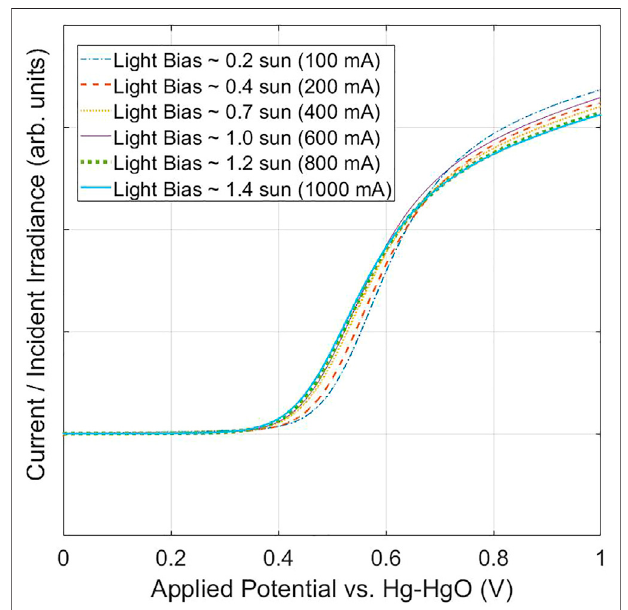
FIGURE 2 | Photocurrent normalized by light intensity vs. applied potential,forvariousintensitiesoftheLEDwhitelightsource.Thelightintensity was determined by a fi tted calibration curve of light intensity vs. LED current, the former measured with a spectroradiometer and integrated over wavelengthforthetotalirradiance.Thesamplewasa26 nmthickepitaxial1% Ti-doped hematite deposited on platinized sapphire.